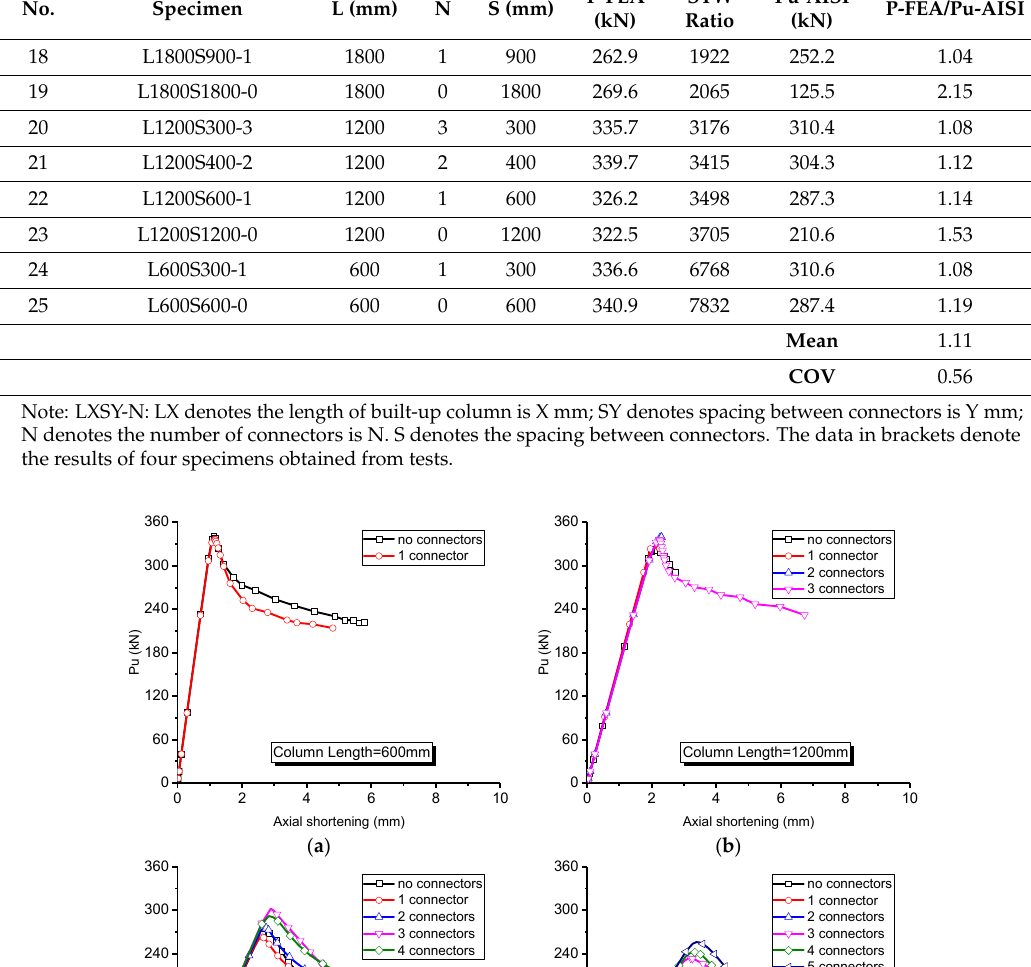
Figure 13. Plastic depressed deformation and Mises stress of tubes (unit: N/m 2 ).